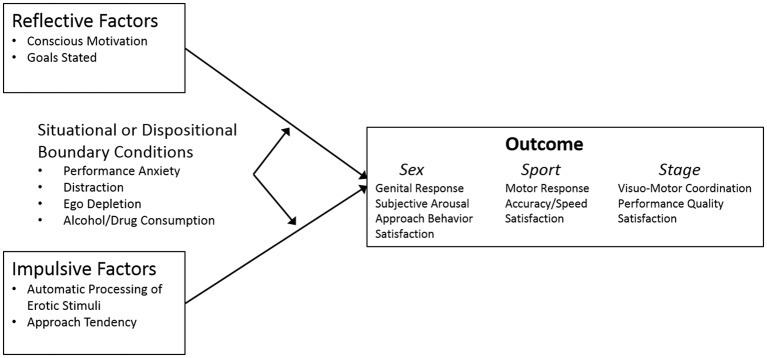
A reflective-impulsive model of the association of performance anxiety and functioning in the domains of sex, sport, and stage performance. Illustration adapted from Hofmann et al., 2009, p.166.